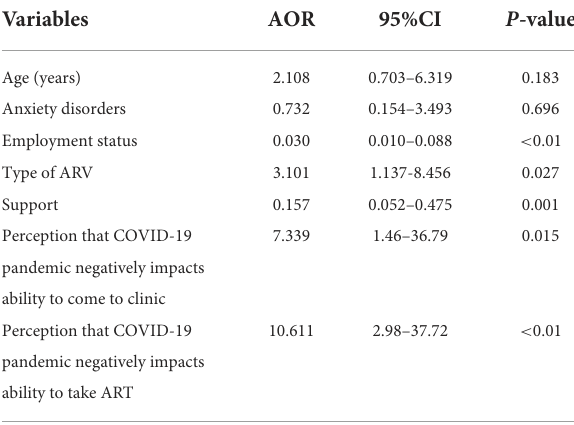
TABLE 3 Multivariate analysis of adherence levels among PLWH ( n =